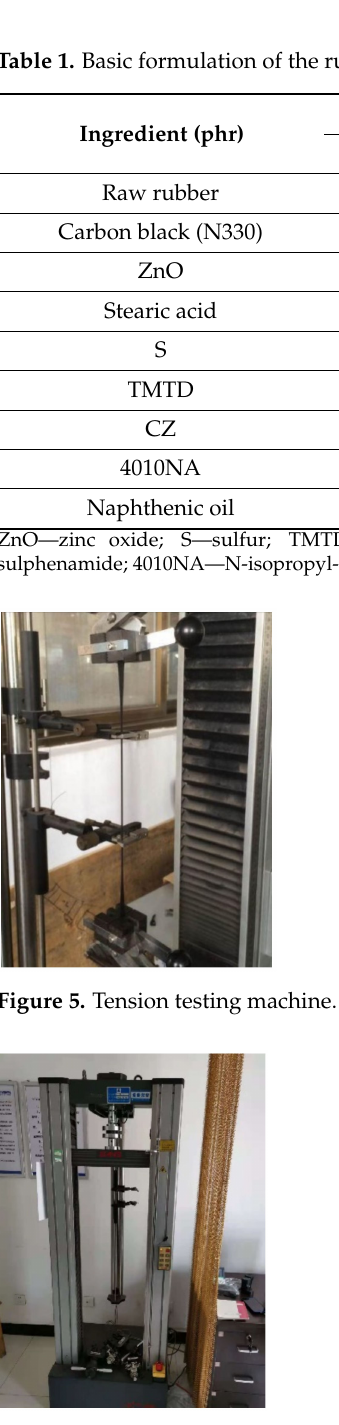
Figure 6. Compression testing